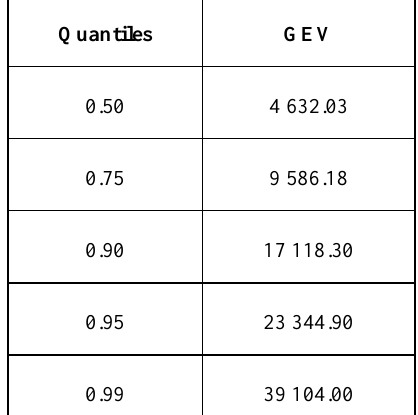
Table 5. Quantiles of fitted GEV for block maxima model for n =